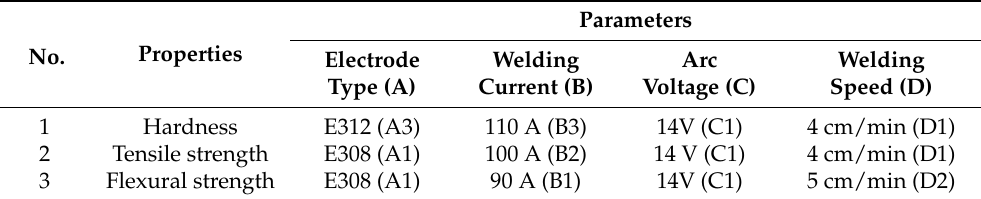
Table 12. Resume of optimal welding parameters based on Taguchi’s “larger is